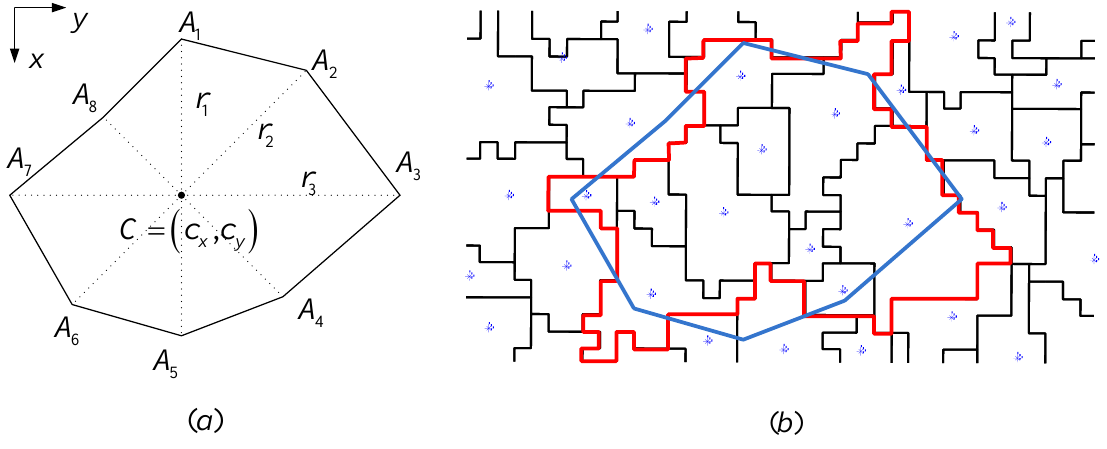
Figure 4. Polygon representation of BSFs. ( a ) Typical polygonal BSF with n = 8 vertices, and ( b ) illustration of watersheds inclusion by the previous